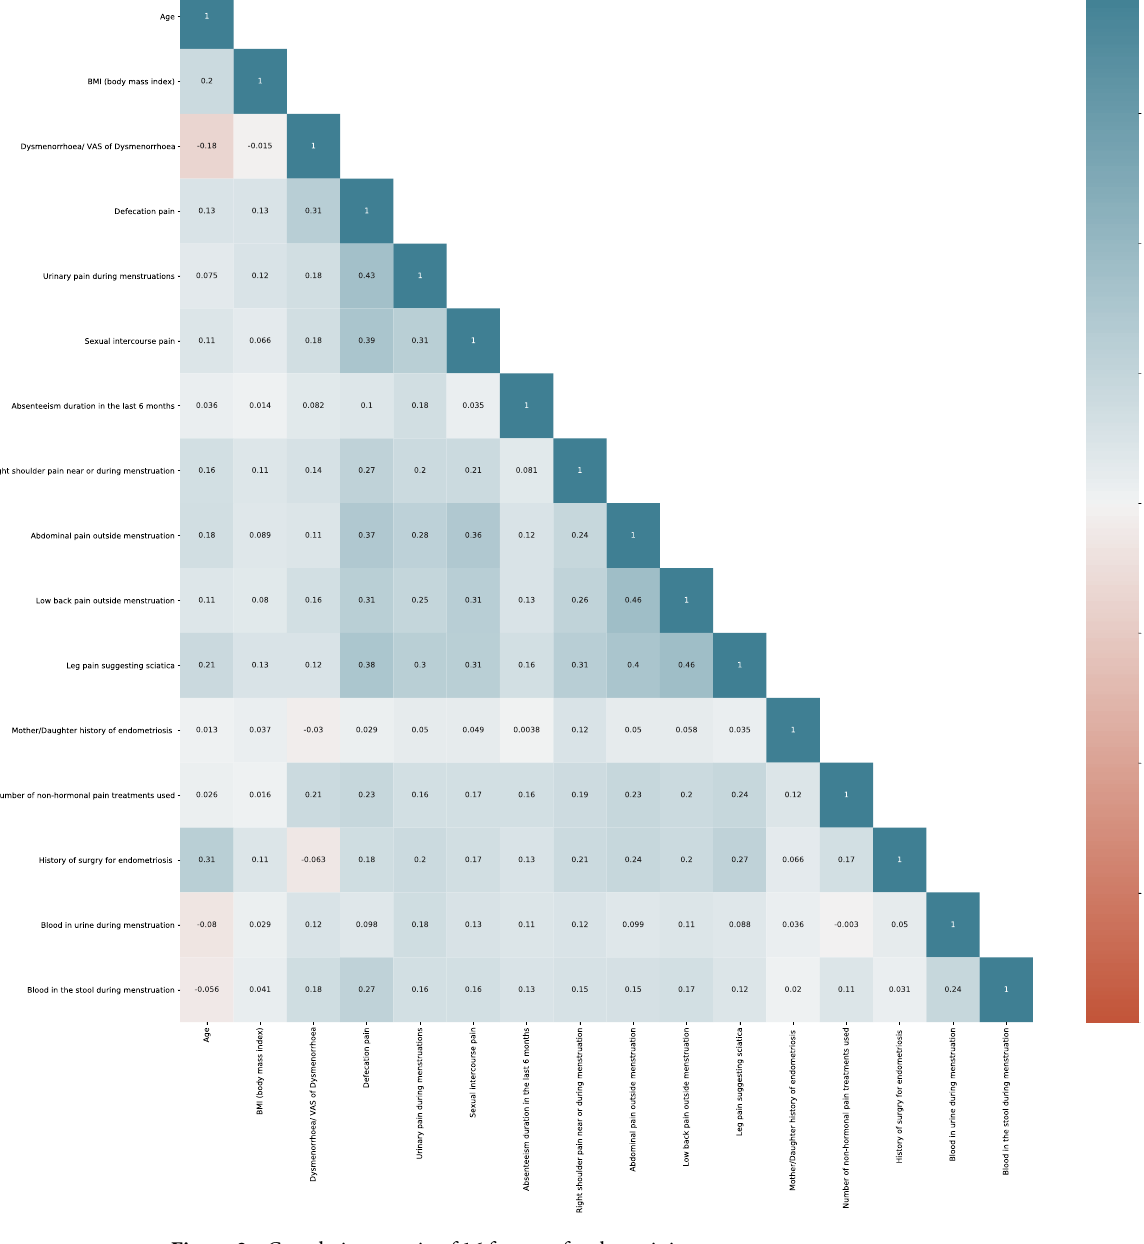
Figure 2. Correlation matrix of 16 features for the training